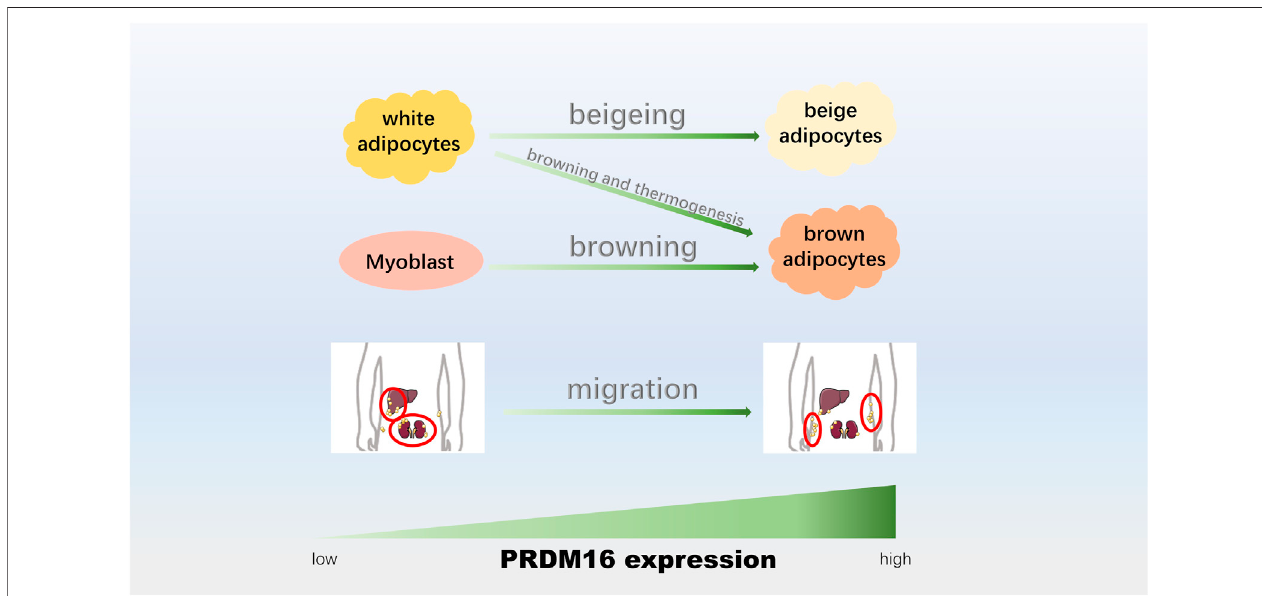
FIGURE 3 | PRDM16 participates in adipocyte transformation and thermogenesis. The upregulation of PRDM16 could promote the beigeing of white adipocytes, adipose tissue browning and thermogenesis, adipogenic differentiation of myoblasts, and conversion from visceral fat to epidermal fat.